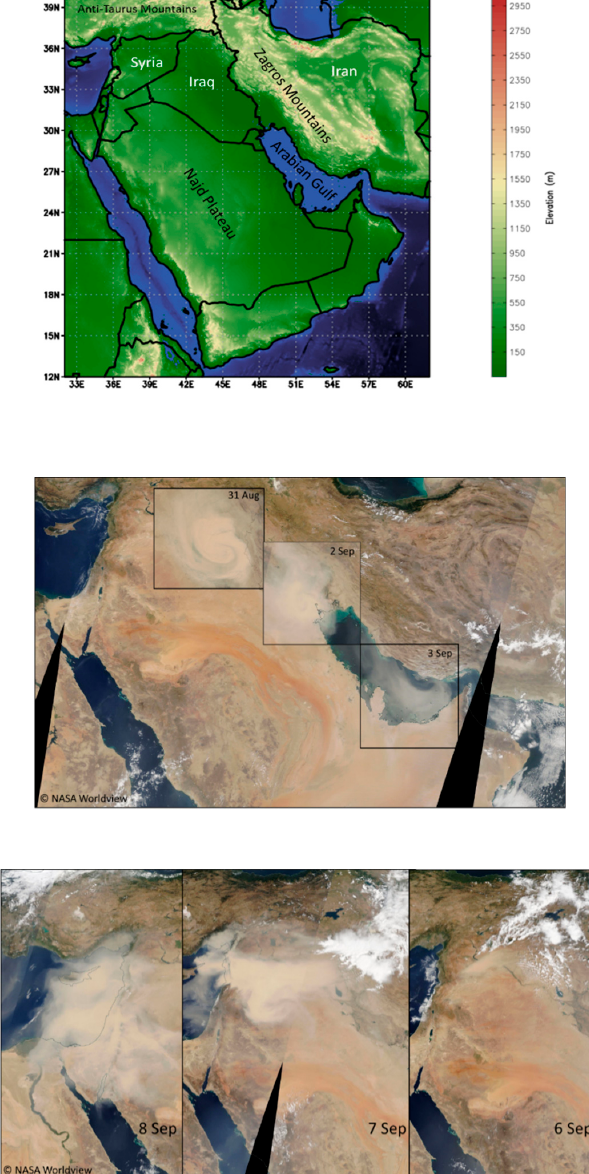
Figure 1. ( a ) Orography map derived from the Earth TOPOgraphy 1 (ETOPO1)database over the study area showing the mountains to the North and East of Iraq and the plains over Iraq and Syria which constitute rich dust source areas where deflatable materials accumulate at the mountains foothills under the action of rain and drainage during winter and drying during summer ( b ) MODIS satellite images showing the development of the dry cyclone over Iraq on 31 August 2015, its migration East then South on 2 September and its decay over the Arabian Gulf on 3 September. ( c ) MODIS satellite images showing the initiation of the dust storm on 6 September 2015 by a density current emanating from the convective clouds seen in white colors over North Syria. The dust storm expanded and intensified on 7 September when a series of density currents occurred from deep convective clouds. The dust cloud then moved westward on 8 September and remained stagnant over the eastern side of the Mediterranean Sea for 2 days. Images credit: NASA